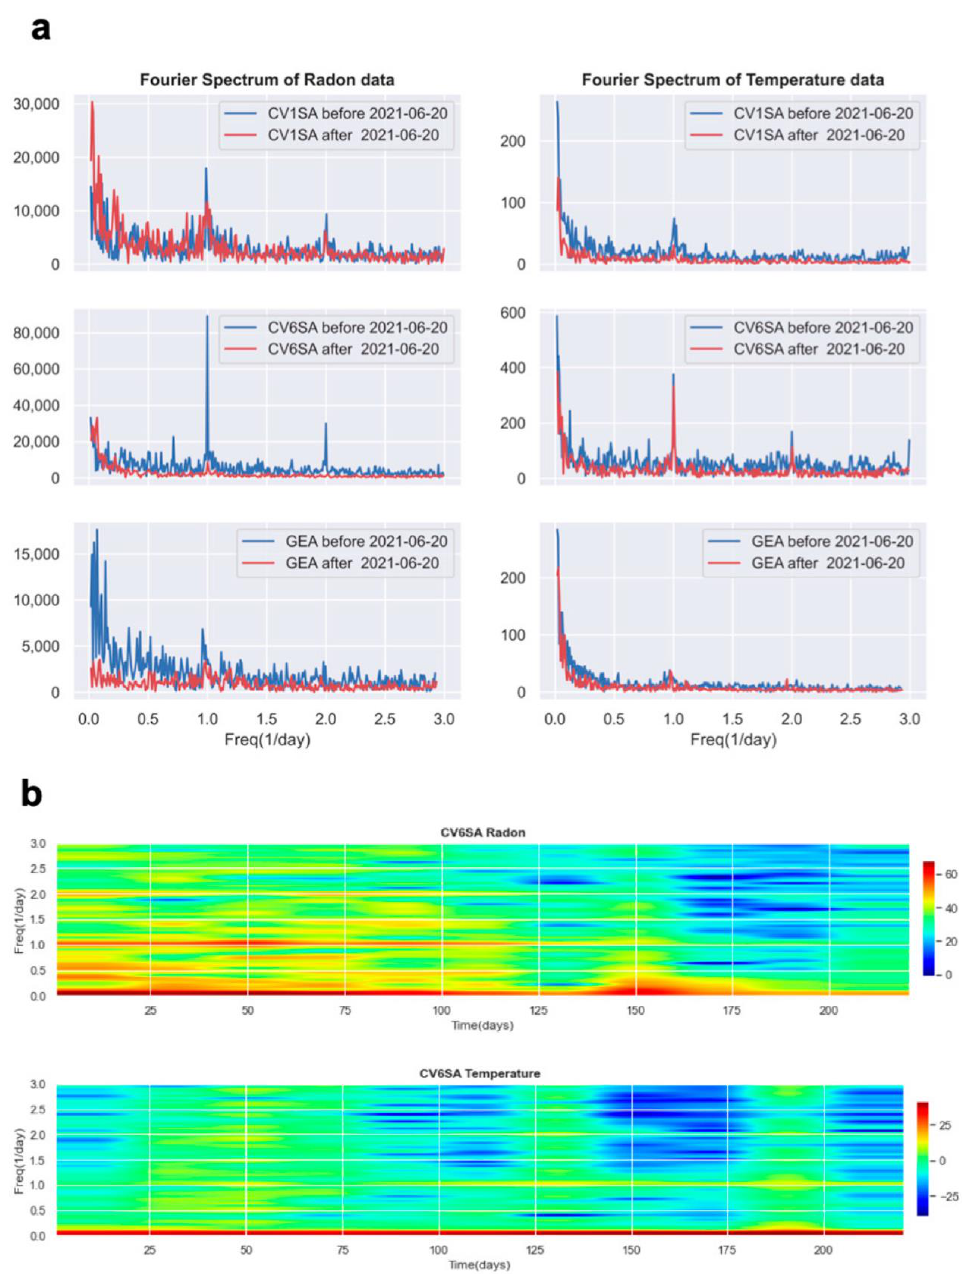
Figure 8. ( a ) Amplitude spectra of the three longest time series of radon (left panels) and temperature (right panels). Blue and red curves refer to data recorded before and after the 20th of June when radon in CV1SA shows a slight change in frequency (Figure 7b). ( b ) Spectrogram of radon concentration and temperature recorded in room CV6SA. Time is measured in days starting from the first day of recording (5 February 2021).